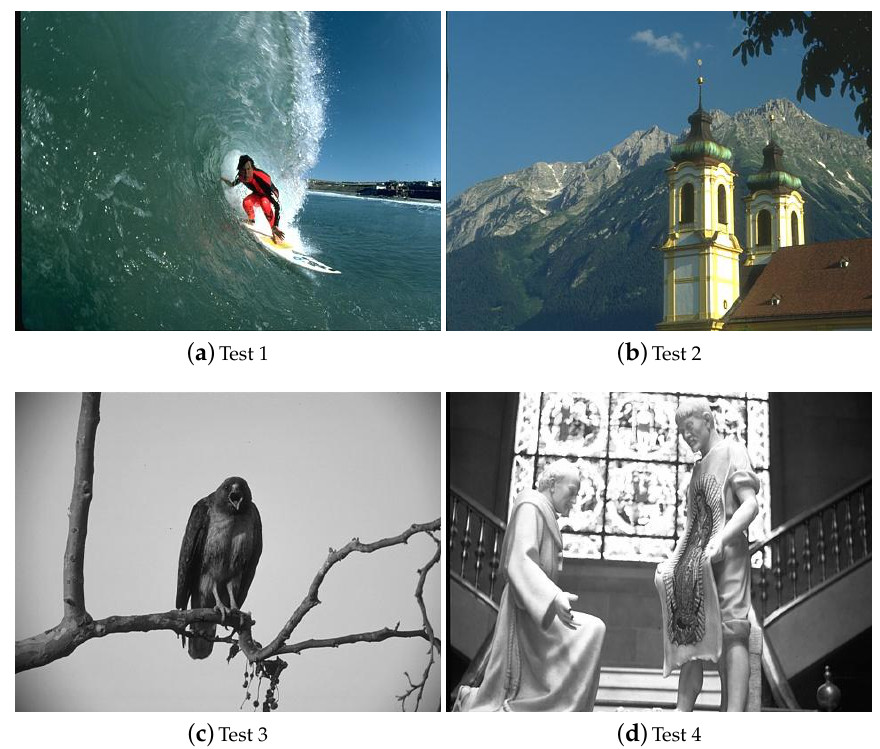
Figure 4. The nature benchmark images that have been